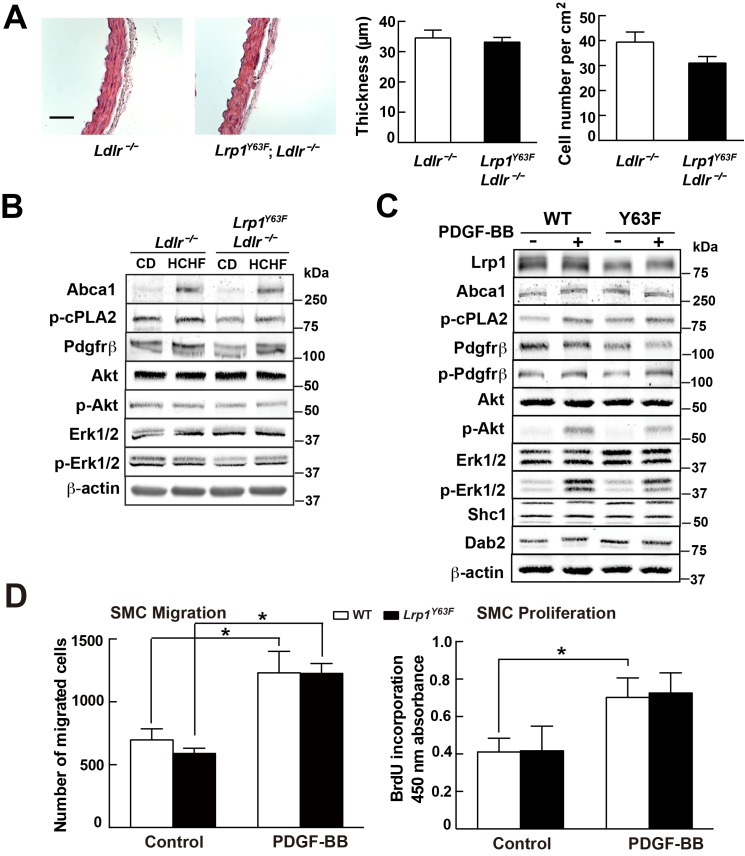
Lrp1Y63F mutation has no effect on atherogenic signaling pathways and morphological phenotype in SMCs.(A) Left: representative images of H&E stained descending thoracic aortas (scale bar = 50 μm). Right: aortic wall thickness and cell number were quantified for the indicated genotypes. Data are expressed mean ±SEM; n = 3 per group and genotype. (B) HCHF diet in Lrp1Y63F;Ldlr−/− mice has no effect on PDGF and TGFβ-mediated signaling in the aorta. Proteins were extracted from whole aorta in Lrp1Y63F;Ldlr−/− and Ldlr−/− mice fed with indicated diets. Expression of proteins involved in PDGF signaling pathways was determined by Western blot analysis. (C) Lrp1Y63F mutation did not affect atherogenic signaling pathways mediated by PDGF in vitro. Primary SMCs from WT and Lrp1Y63F mice were incubated with or without 10 ng/ml PDGF-BB for 10 min. Expression of proteins involved in PDGF signaling were determined by Western blot analysis. (D) Lrp1Y63F mutation did not alter SMC functions in vitro. Primary cultured SMCs from WT and Lrp1Y63F mice were incubated with or without 10 ng/ml PDGF-BB under indicated conditions, then cell migration (left) and proliferation (right) were determined. Values from three independent experiments are expressed as mean ±SEM. *p<0.05.